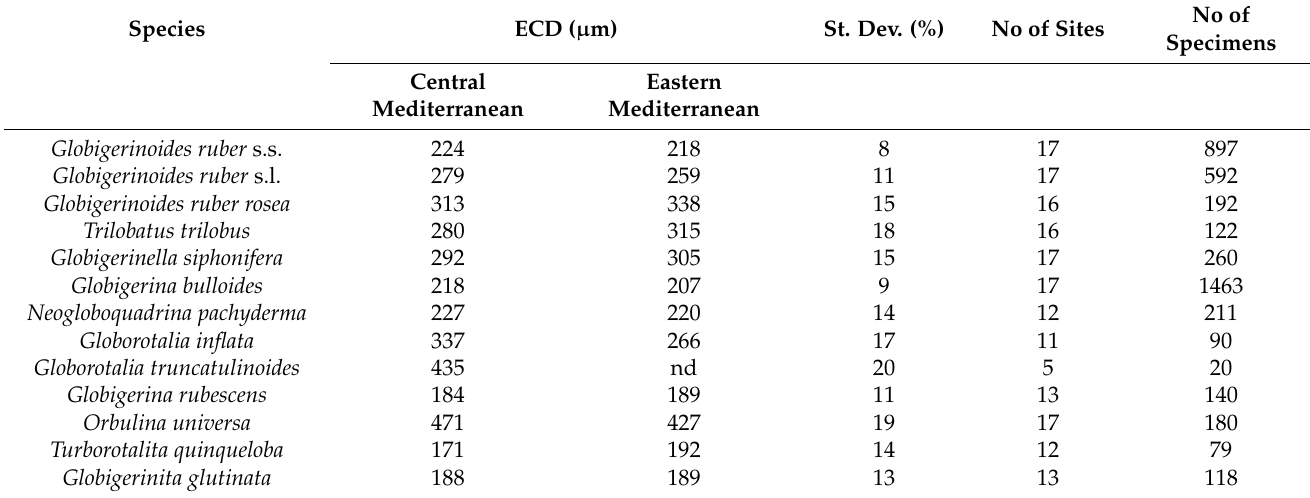
Table 3. Average population size of the identified planktonic foraminifera species within the Central Mediterranean (this study) and comparison with the Eastern Mediterranean basin [24]. The number of sampling locations that each species was encountered is also shown together with the total number of specimens counted. nd: not determined. No of Species ECD ( µ m) St. Dev. (%) No of Sites Specimens Central Eastern Mediterranean Mediterranean Globigerinoides ruber s.s. 224 218 8 17 897 Globigerinoides ruber s.l. 279